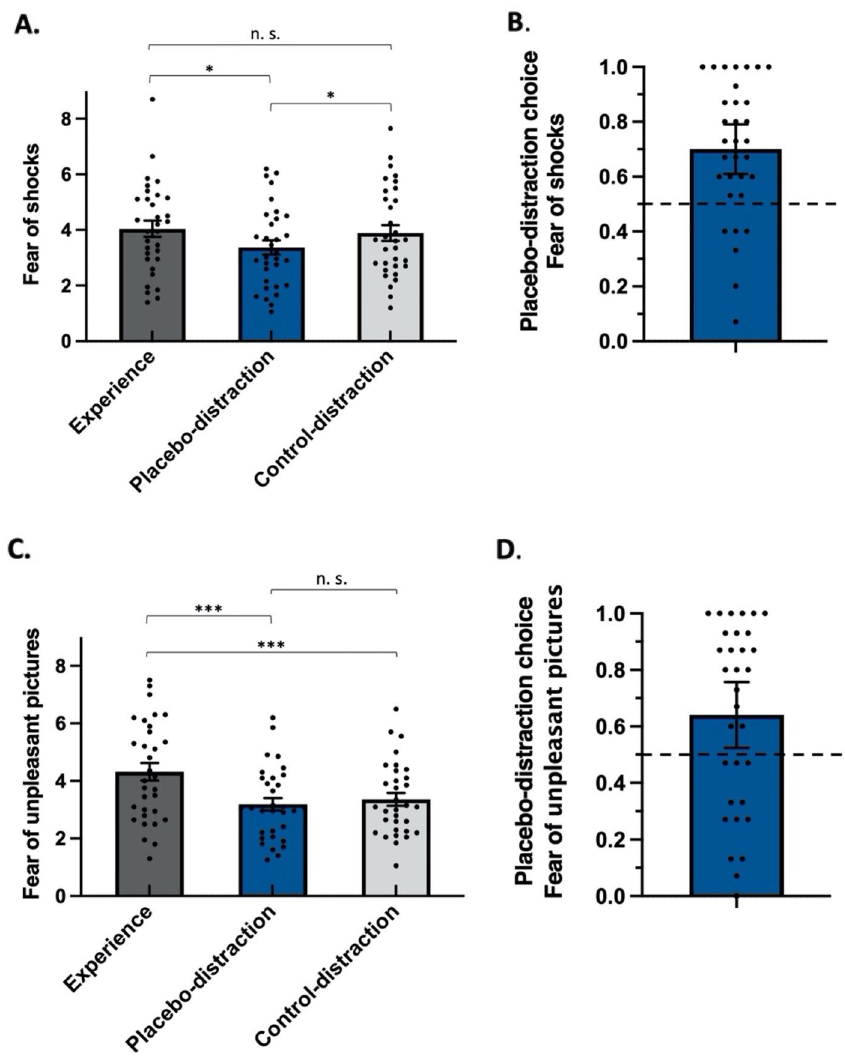
Figure 2. Study results. Self-reported fear of shocks (y-axis) ( A ) and fear of unpleasant pictures (y-axis) ( C ) for experience, placebo-distraction, and control-distraction. Higher values denote enhanced fear of shocks/ unpleasant pictures. * p < 0.05; ** p < 0.01; *** p < 0.001. Error bars represent standard errors. ( B ) Percentage of trials (y-axis) participants behaviorally chose the placebo-distraction over the control-distraction when regulating fear of shocks and ( D ) when regulating fear of unpleasant pictures. The bars represent 95% CIs. Note that most individual points fall above the horizontal lines, which represent a 50% "no preference"